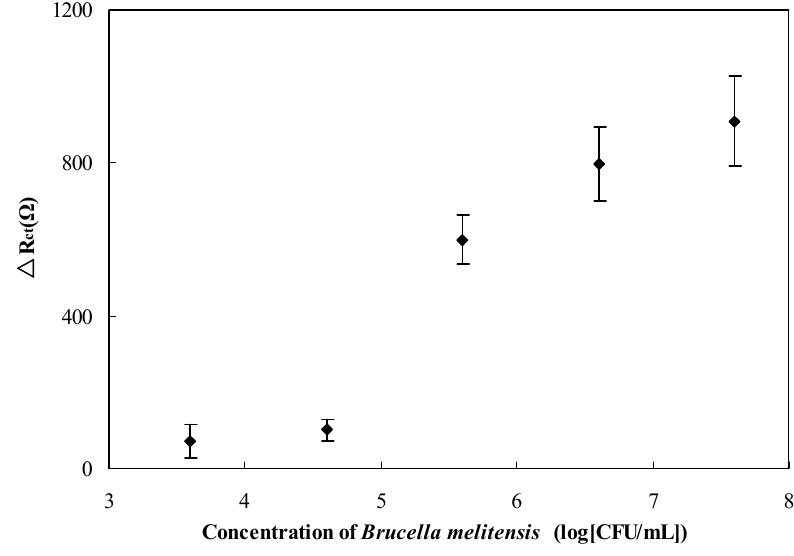
Figure 7. Detection of Brucella melitensis in milk samples. The mean of each ∆ R calculated from three independent measurements of GNP-SPCE